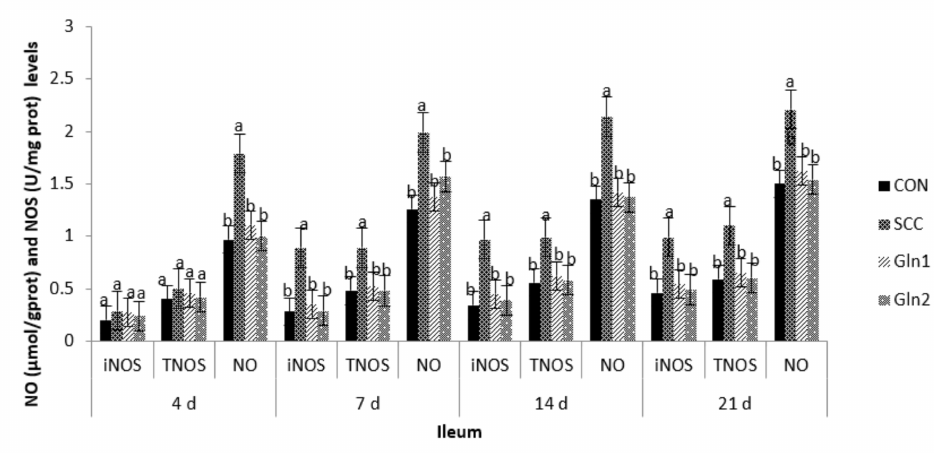
Figure 1. Effect of Gln on the serum and intestinal mucosa NO and NOS levels of broiler chickens that received S . Enteritidis. CON = a basal diet without added Gln and no challenged group, SCC = a basal diet without added Gln and received 2.0 × 10 4 CFU/mL of S. Enteritidis suspension group, Gln1 = a basal diet plus 0.5% Gln and fed 2.0 × 10 4 CFU/mL of S. Enteritidis suspension group, Gln2 = a basal diet plus 1.0% Gln and fed 2.0 × 10 4 CFU/mL of S. Enteritidis suspension group. a,b Means within a row with different superscripts are different at p < 0.05. n =